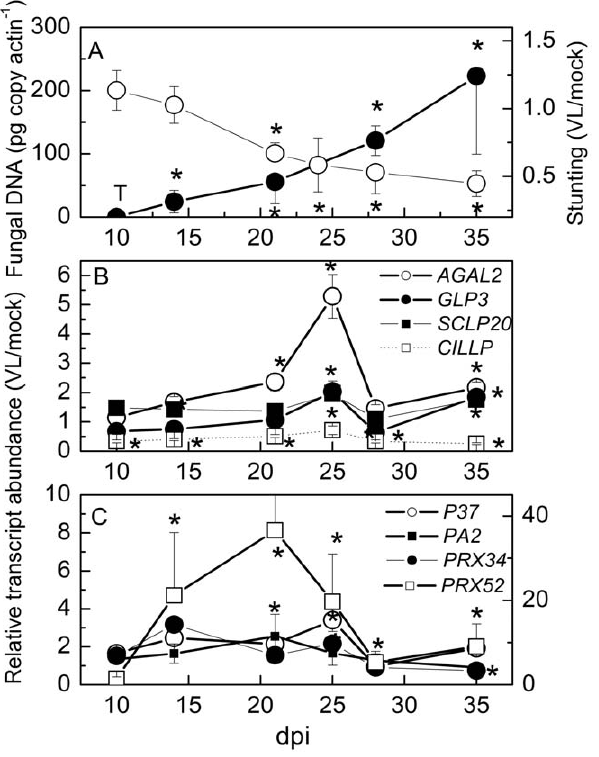
Figure 2. Fungal DNA, stunting of the rosette, and relative transcript abundance of genes encoding apoplastic proteins from Arabidopsisthaliana that were either induced or repressed by treatment with Verticilliumlongisporum (VL43). (A) Typical time course of stunting white symbols) and VL43 DNA (black symbols) in Arabidopsis rosettes (n $ 4 biological replicates 6 SE, except 10 dpi, where pooled samples were analyzed due limited material), T=traces of VL43 DNA detected. Stunting was determined as projected rosette area of VL infected plants/projected rosette area of mock inoculated plants. (B) Transcript levels of CILLP , SCPL20 , AGAL2 and GLP3 and (C) transcript levels of the peroxidases PRX52 (right axis), PRX34 , P37 and PA2 (left axis). Transcript levels were normalized to actin and expressed as transcript abundance in VL-infected plants/transcript abundance in mock-inoculated plants (n $ 6 biological replicates 6 SE). *indicate significant differences between mock and VL-infected plants. doi:10.1371/journal.pone.0031435.g002 PLoS ONE |